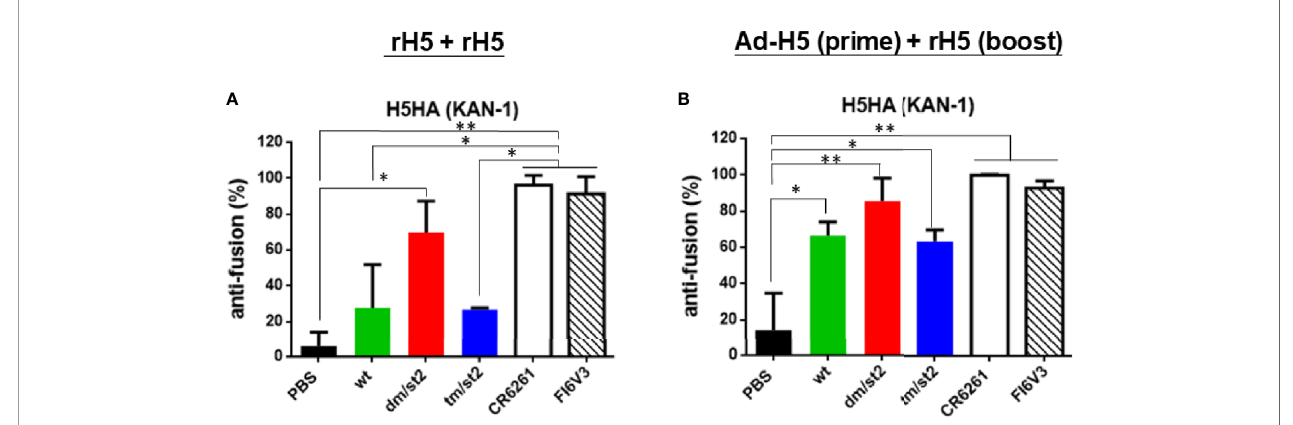
FIGURE 5 | Inhibition of HA stem-mediated fusion activity.HA stem-mediated fusion inhibition activity was measured using a luciferase-based cell-cell fusion assay.Stem- binding mAbsCR6261 and FI6v3were used as the positive controls. (A) HA stem-mediatedfusion inhibition activity ofantisera elicited by rH5 + rH5 regimen. (B) HA stem- mediatedfusion inhibition activity of antisera elicited byAd-H5 (prime) + rH5 (boost) regimen. Data were analyzedusing one-way ANOVA. (*p < 0.05, and **p <